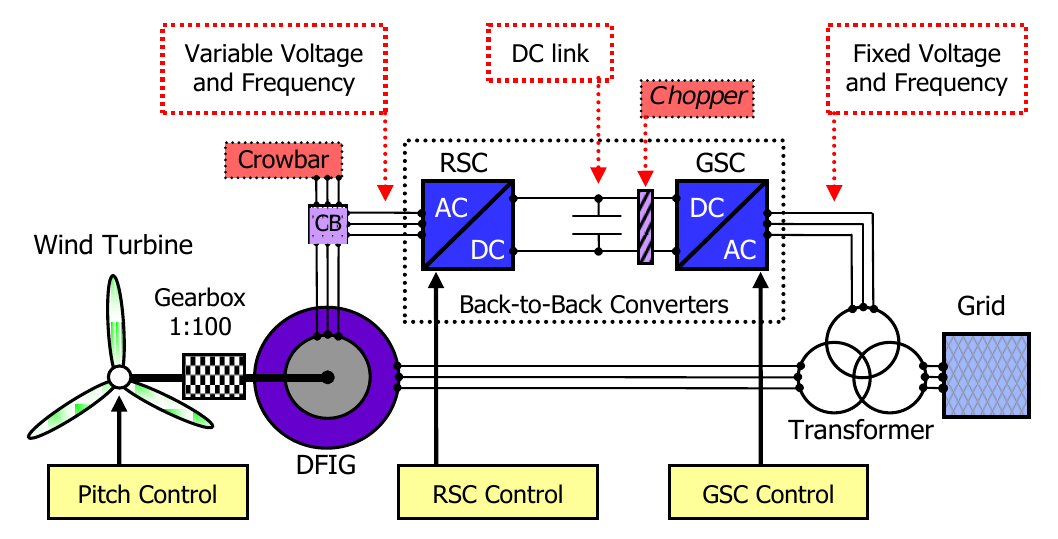
Figure 3. Schematic diagram of a single DFIG based wind